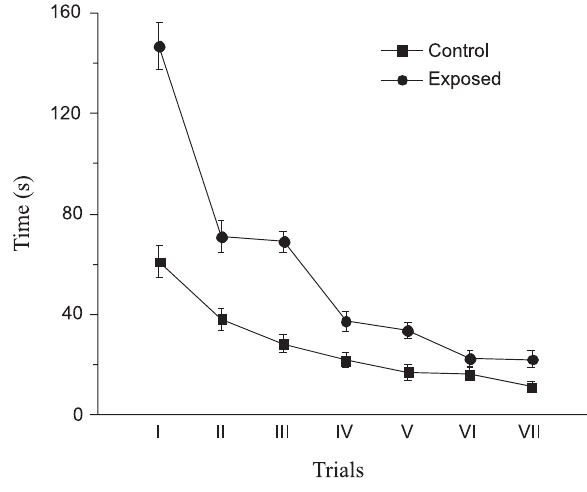
Figure 1 - Morris water maze escape latencies. Mean ± STDEV for both groups of animas according to trial group. Both groups of animals improved their water maze acquisition performance i.e. decreased their latency to find the platform from the first to the last trial However, there was a notable dif- ference in the latency times of the two groups during the training